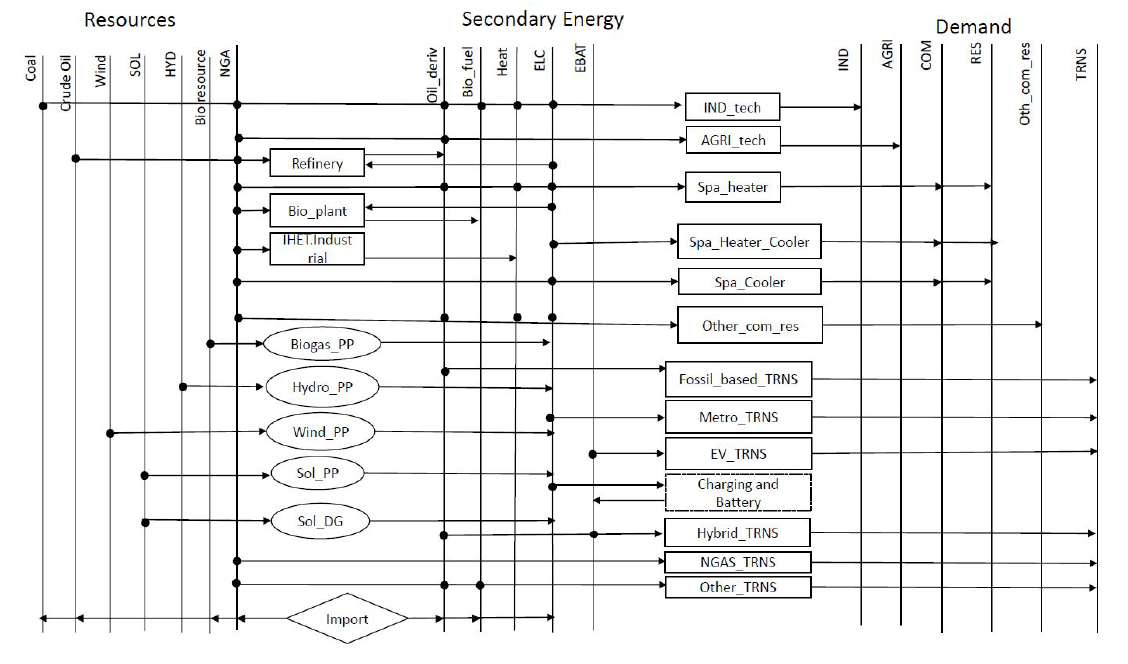
Figure 1. Overview of the reference energy system (RES) in the Greater Montreal region. SOL—